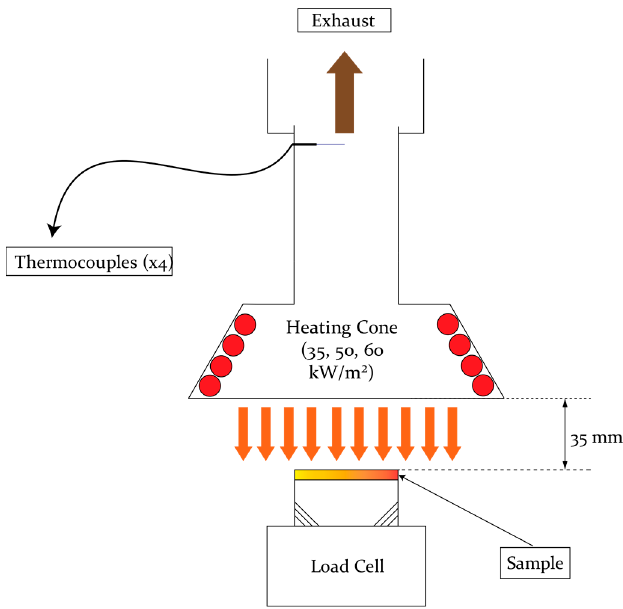
Figure 1. Schematic representation of the mass loss cone calorimeter.